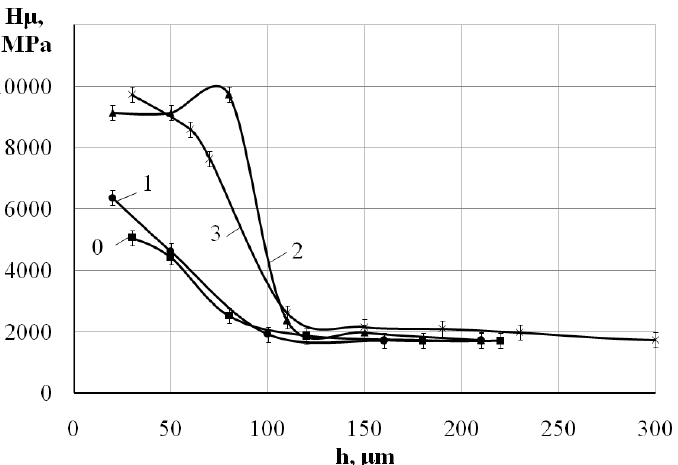
Figure 3. The distribution of the micro hardness over the depth of the layer, beginning from the surface of the specimen made of steel C22: 0 — the ESA process by aluminum at W p = 3.40 J; after nitriding process with the use of the nitrogen-containing paste and alloying by the electrode-tool made of steel C22 at the discharge energy (W р ): 1 — W р = 0.13; 2 — W р = 0.52, and 3 — W р = 3.4 J.